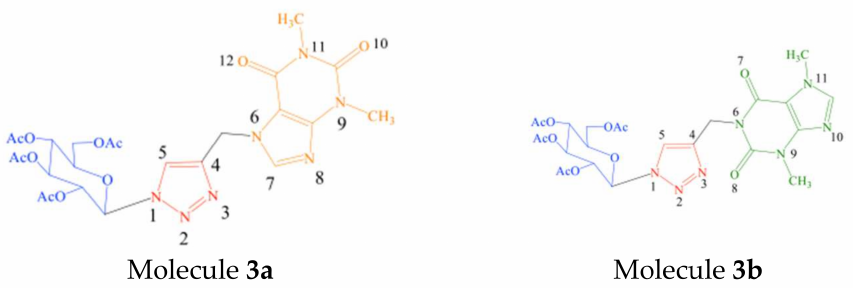
Figure 15. Referenced atoms in Table